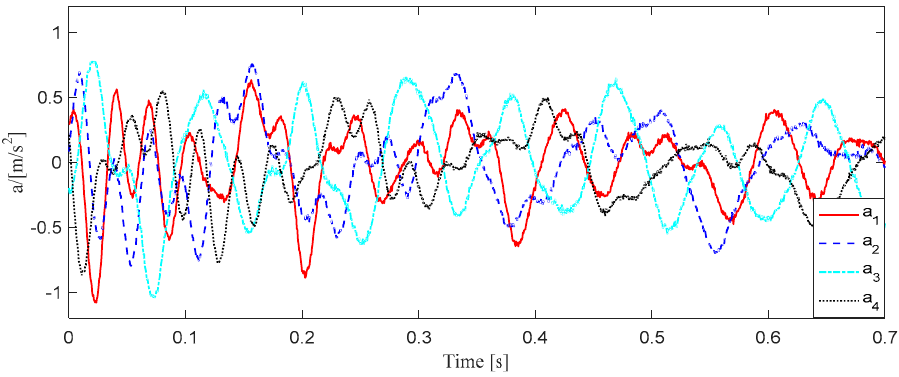
Figure 4. The simulated structural response of sensors a (cid:2869) ~ a (cid:2872) .